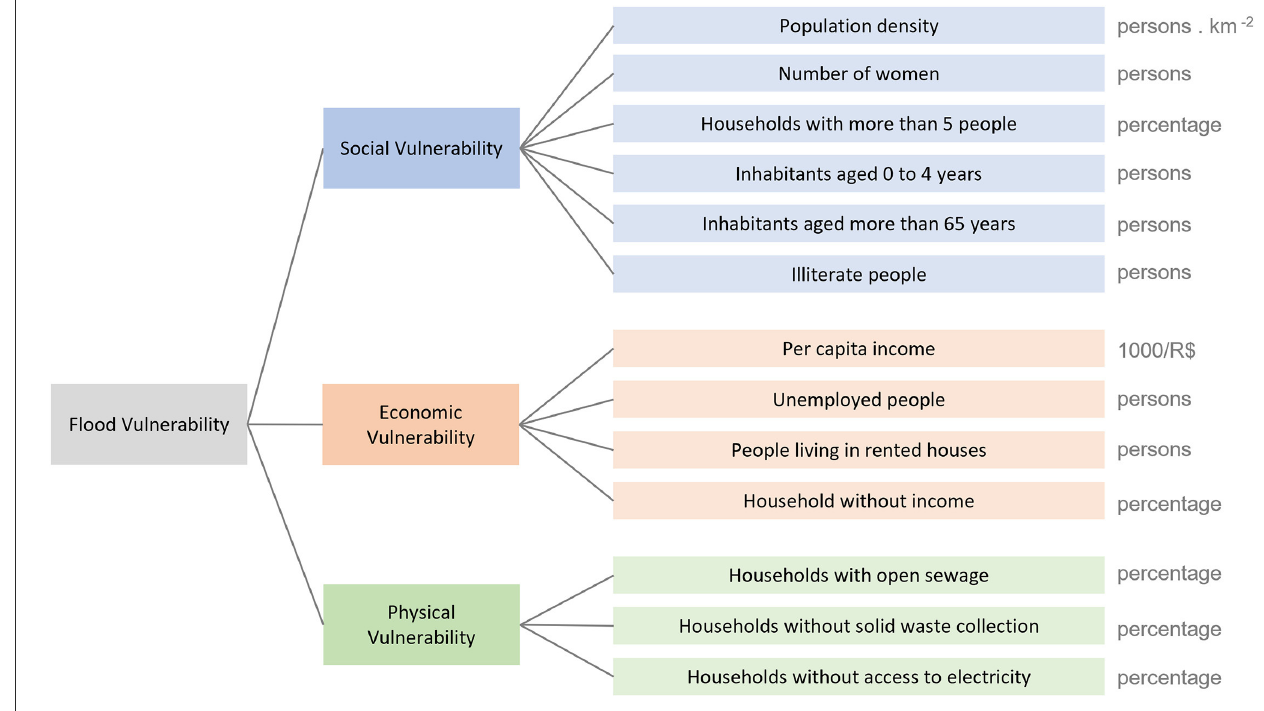
FIGURE3 Input flood vulnerability indicators organized hierarchically. The units used to measure each indicator are indicated in